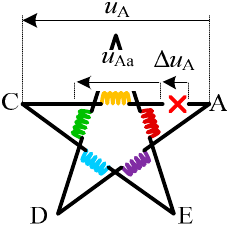
Figure 6. Single open-phase fault in a pentacle-connection mode.